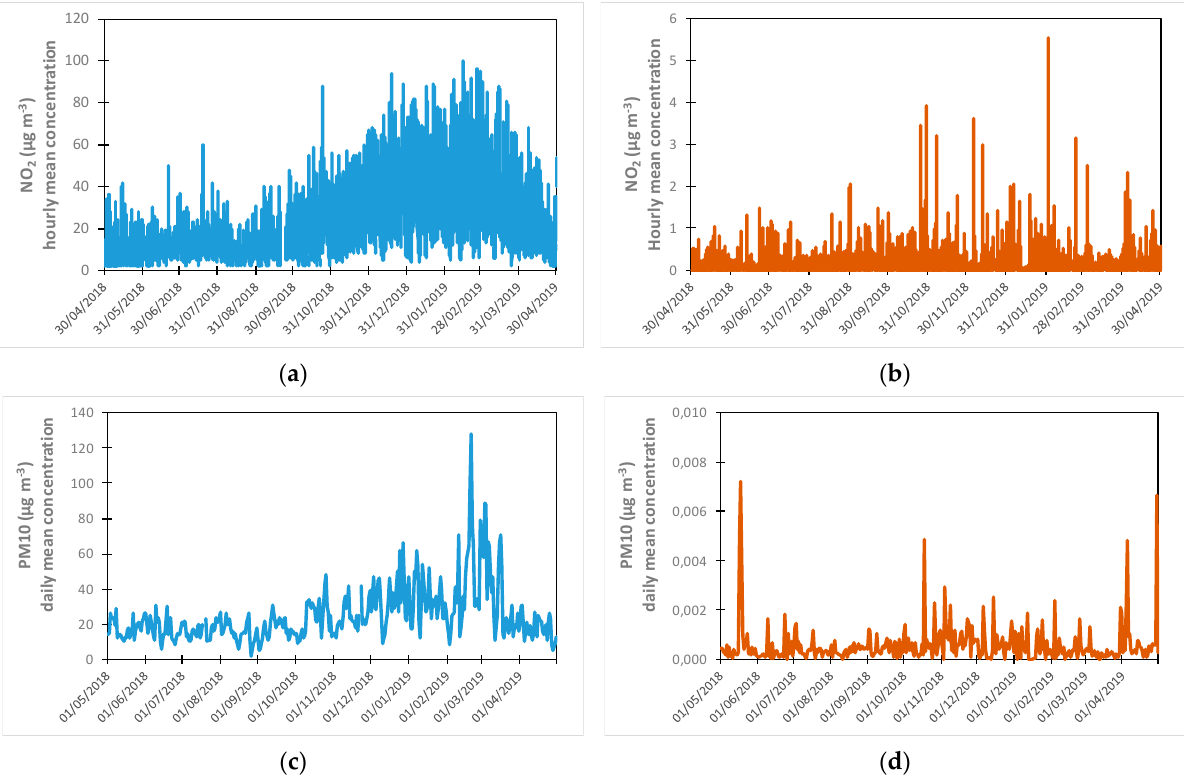
Figure 5. Time pattern of observed and modelled hourly NO 2 (panel a , b ) and daily PM10 (panel c , d ) concentrations for the reference period (1 May 2018–30 April 2019) at site R1. The observed and modelled seasonal mean values for the reference period and the ranges for the daily average concentrations of the four toxic elements (As, Cd, Ni, Pb) and benzo(a)pyrene (BaP) are reported in Table 5; the same table also shows their mean and maximum relative contributions to the ambient levels due to the plant’s emission. Table 5. Mean and min-max range [square brackets] for the measured (Meas.) and modelled (Mod.) daily average concentrations (ng m − 3 ) and mean and maximum relative contributions of the plant’s emission to the ambient levels of toxic elements and benzo(a)pyrene at site R1. (CS: cold season; WS warm